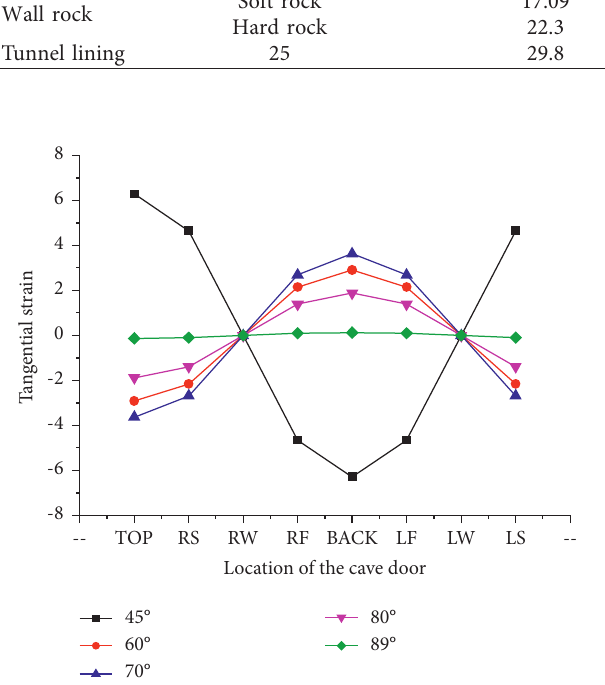
Figure 5: Tangential strain of opening section.